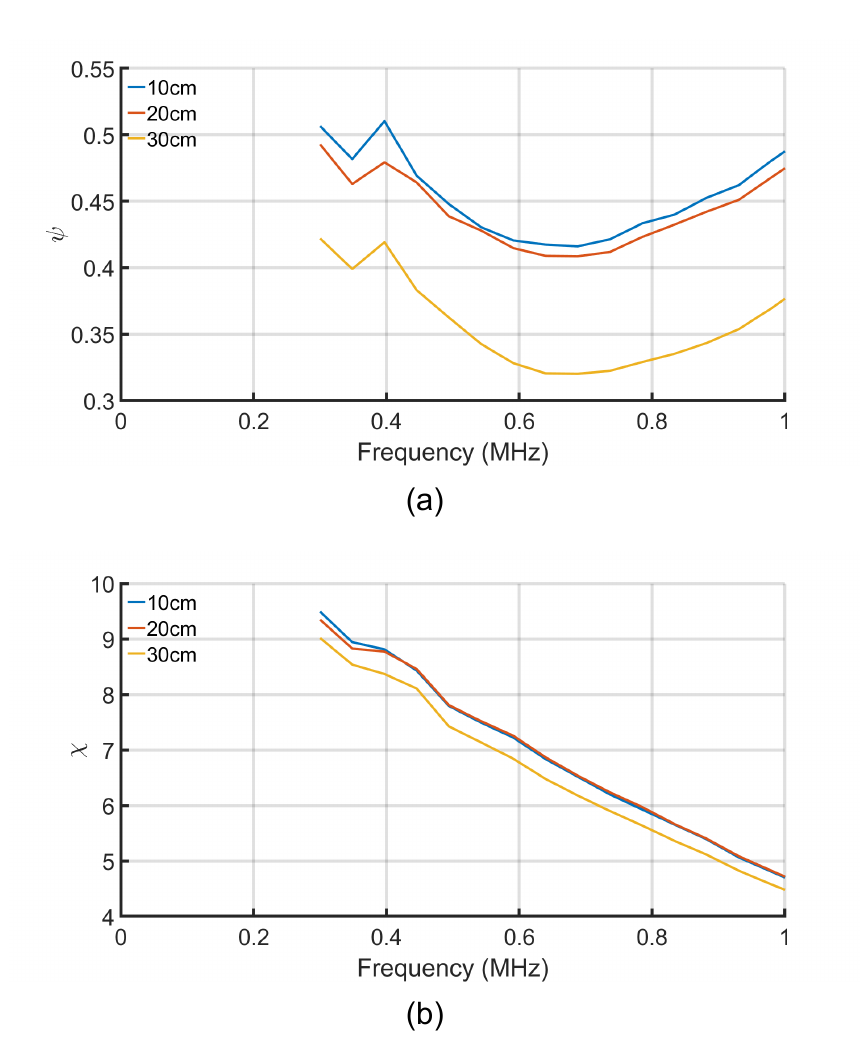
Figure 5. The measured ψ and χ versus the separation distance and the frequency: ( a ) The ψ coefficient. ( b ) The χ coefficient.